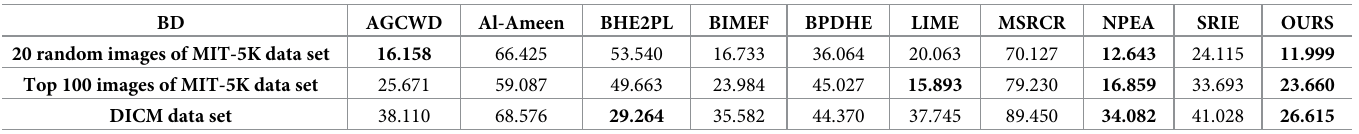
Table 14. Average image brightness difference values of three groups of